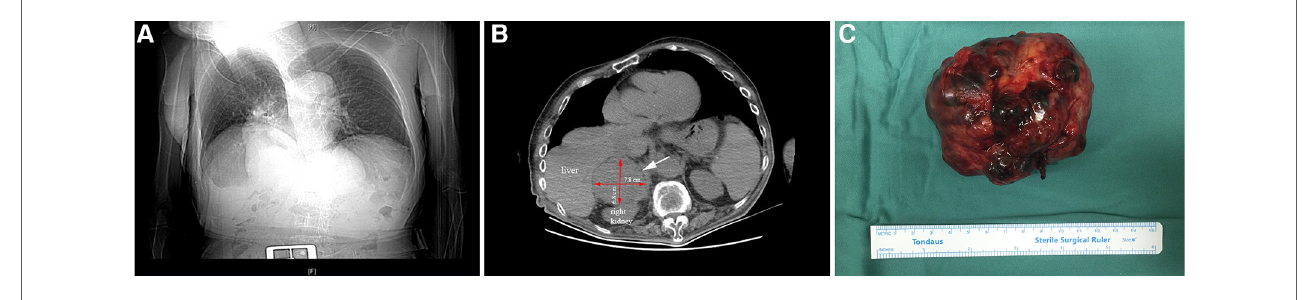
FIGURE 1 X-ray of chest shows that the patient had scoliosis ( A ). The white arrow points to the location of the tumor. The red arrows indicate the length and width of the mass ( B ). Postoperative mass specimen of adrenocortical oncocytic carcinoma ( C